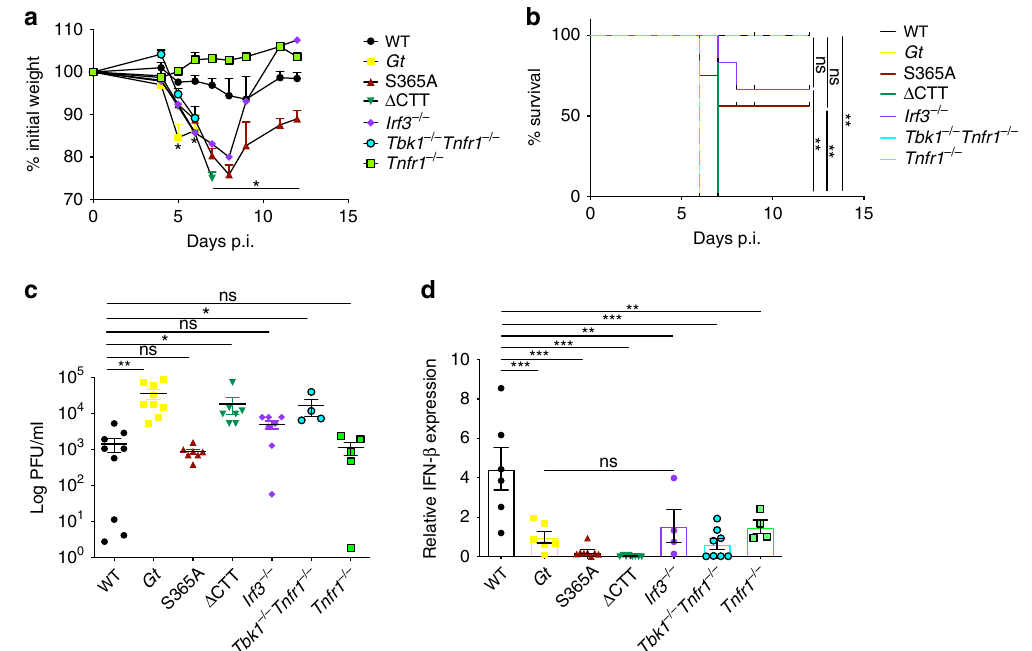
Fig. 5 STING S365A and Irf3 − / − mice phenocopy resistance to HSV-1. Mice were ocular infected with 1 × 10 5 PFU of HSV-1 (strain 17). a Percentage of initial weight following infection. b Survival of infected mice. c Viral titers in the brain stem. d Relative Ifnb expression from brain stems. a , b n = 7 mice per genotype. Representative results of at least two independent experiments, each yielding similar results. c , d n = 3/5 mice per genotype. Combined results from two independent experiments, each yielding similar results. Center and error bars show mean and SEM. Analyzed with one-way ANOVA and